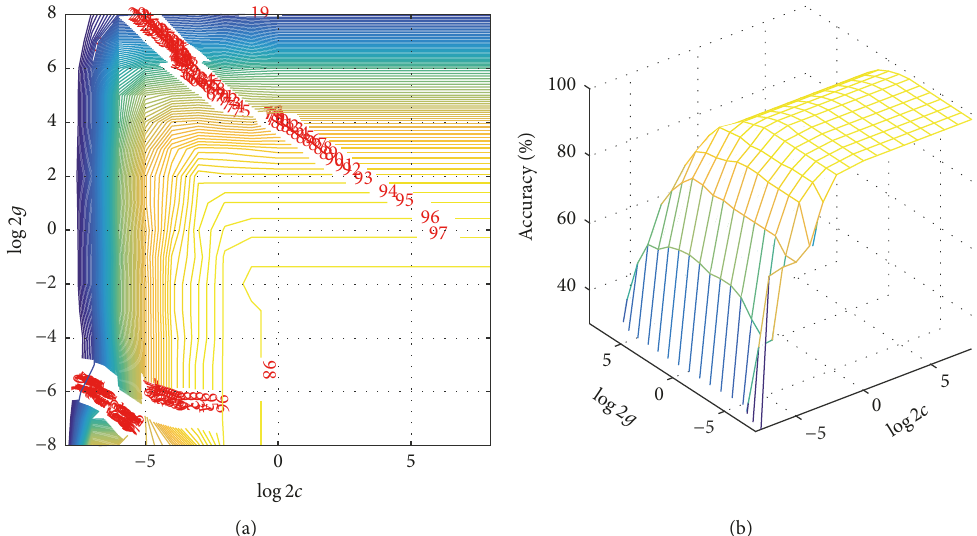
Figure 9: Results of the Grid Search algorithm: (a) contour chart; (b) 3D view.